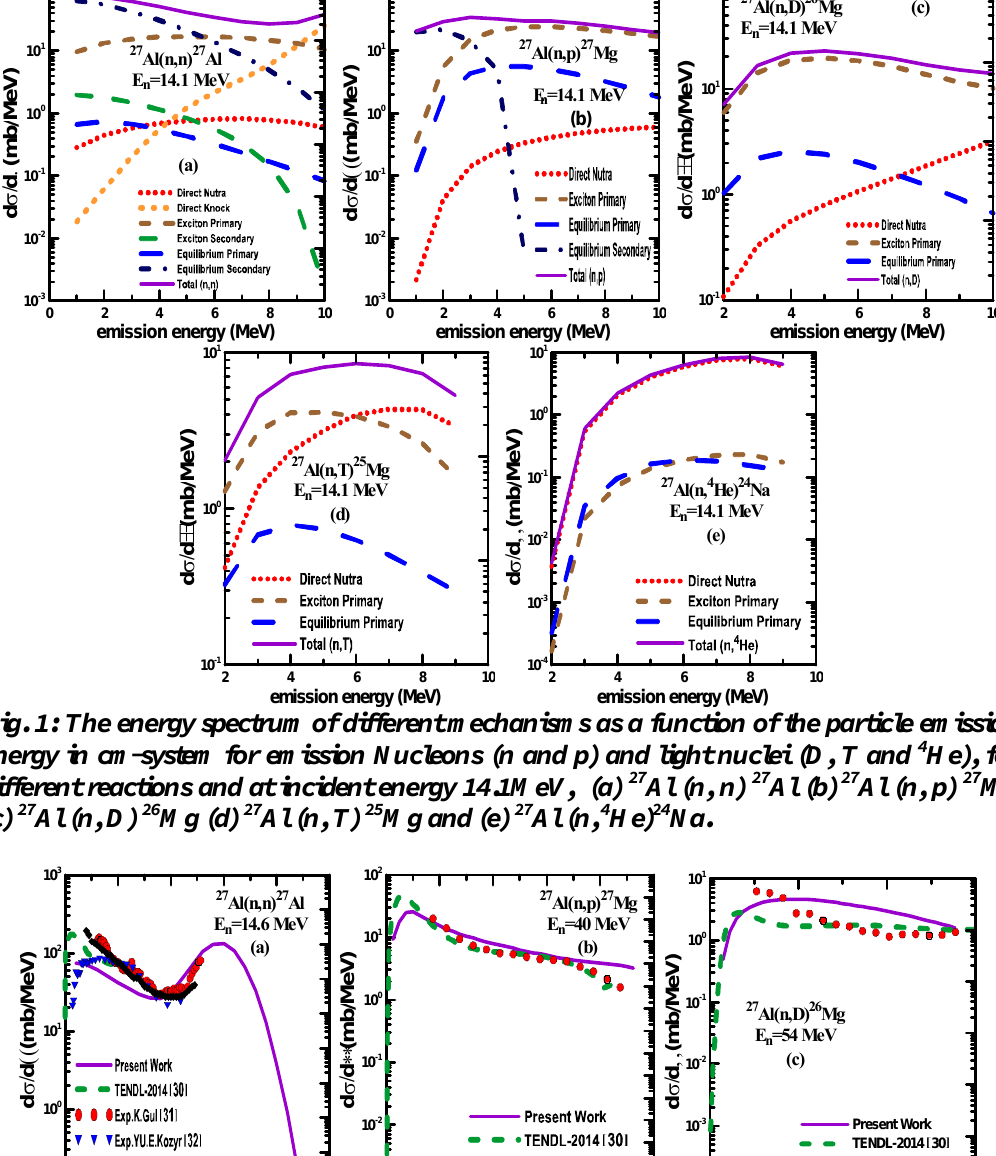
Fig. 2: A comparison between the calculated energy spectrum with refs [30-34], as a function of particle emission energy, at the cm - system, the energy of the incident neutron was (14.6, 40, 54) MeV. (a) 27 Al (n, n) 27 Al. (b) 27 Al (n, p) 27 Mg (c) 27 Al (n, D) 26 Mg (d) 27 Al (n, T) 25 Mg (e) and 27 Al (n, 4 He) 24